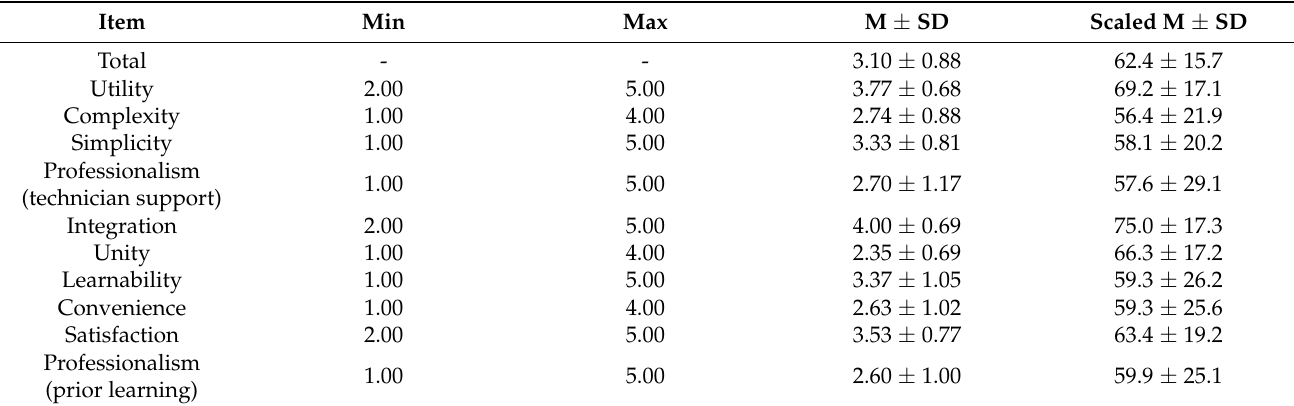
Figure 3. SUS scores and standards.